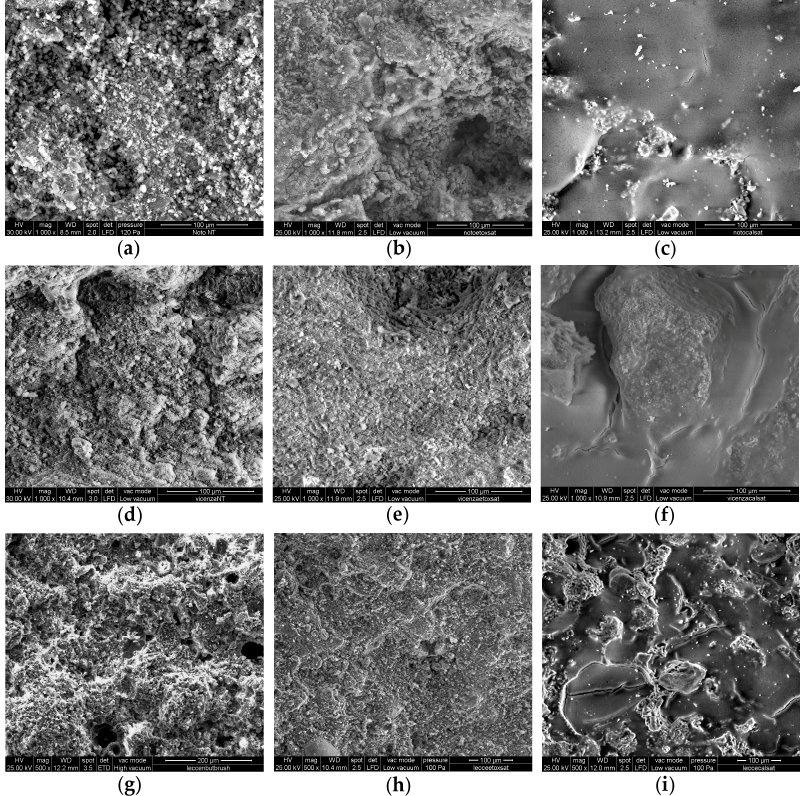
Figure 9. SEM images of samples treated with protocol B1: ( a ) Noto untreated; ( b ) Noto ET; ( c ) Noto CA; ( d ) Vicenza untreated; ( e ) Vicenza ET; ( f ) Vicenza CA; ( g ) Lecce untreated; ( h ) Lecce ET; ( i ) Lecce CA.